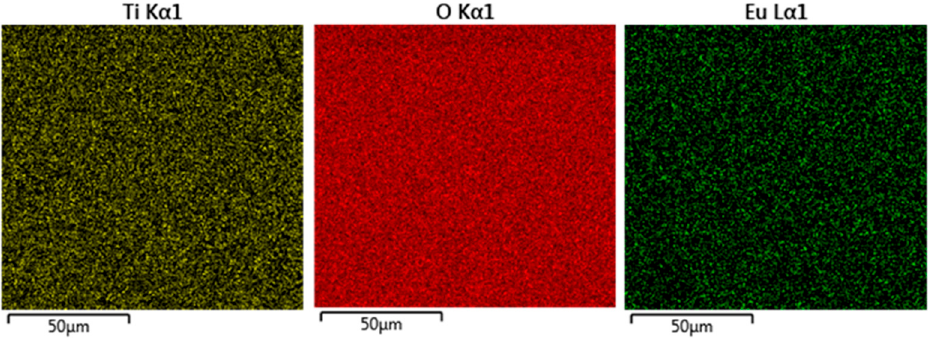
Figure 7. EDX elemental mapping of Eu-doped TiOx thin film.